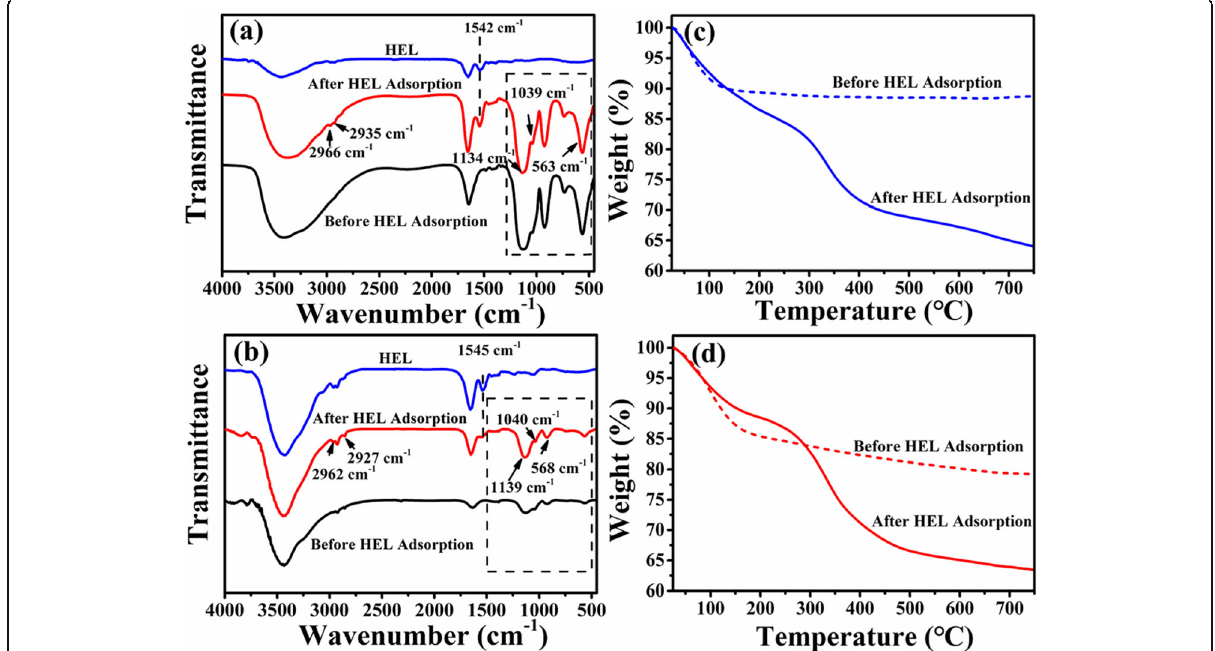
Fig. 8 FT-IR spectra and TGA curves of microspheres before and after HEL adsorption . a FTIR spectra and c TGA curves of ATP-CG microspheres, b FTIR spectra and d TGA curves of ATP-CL microspheres